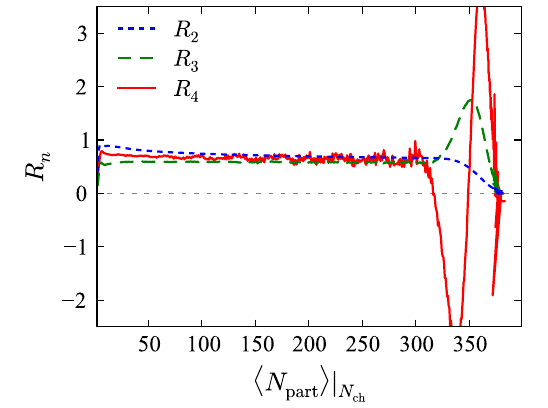
Fig. 2 Relative contribution of N part fluctuation, see Eqs. (16,17,18), √ s = 7 . 7 GeV in Au+Au collisions for c 2 , c 3 and c 4 at